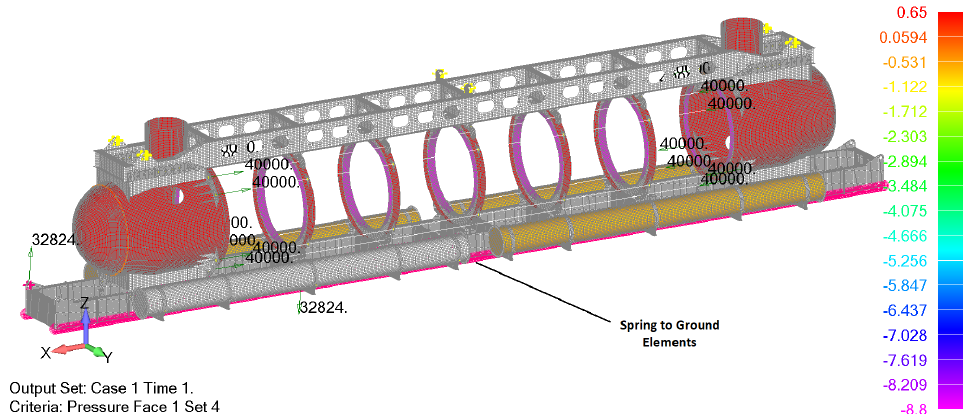
Figure 16. Loads and vertical displacements of the assembled structure for the emergency lifting in damaged condition (force in N, pressure in MPa)